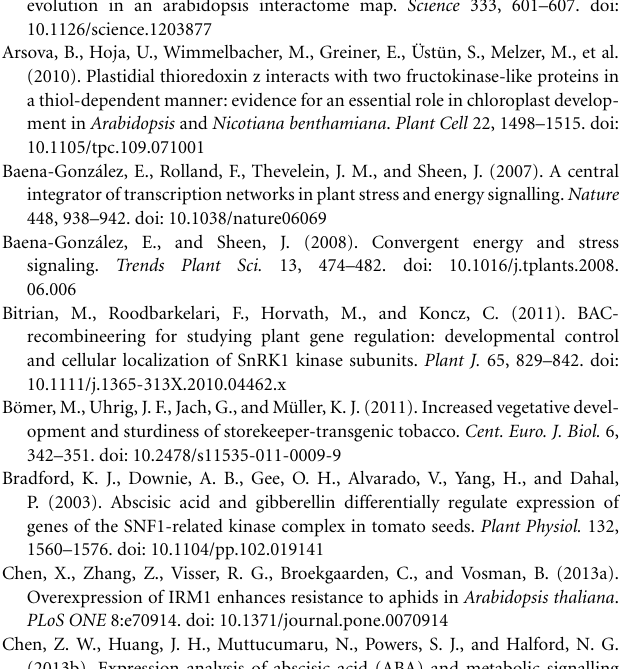
Supplementary Table S2 | Nucleotide sequences of primers used in this